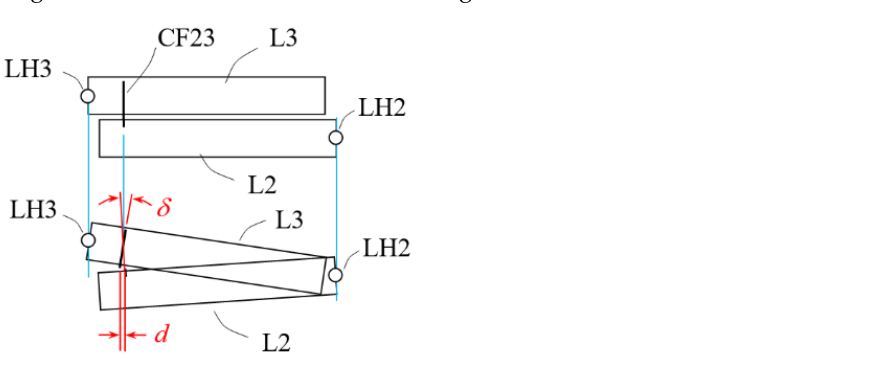
Figure 4. Conceptual design B, assembled structure of multi-planar layout with monolithic hinges, but “L-shape” flat spring couplers between levers; ( a ) coupler CF23 is “pull” type; ( b ) CF23 is “push” type.